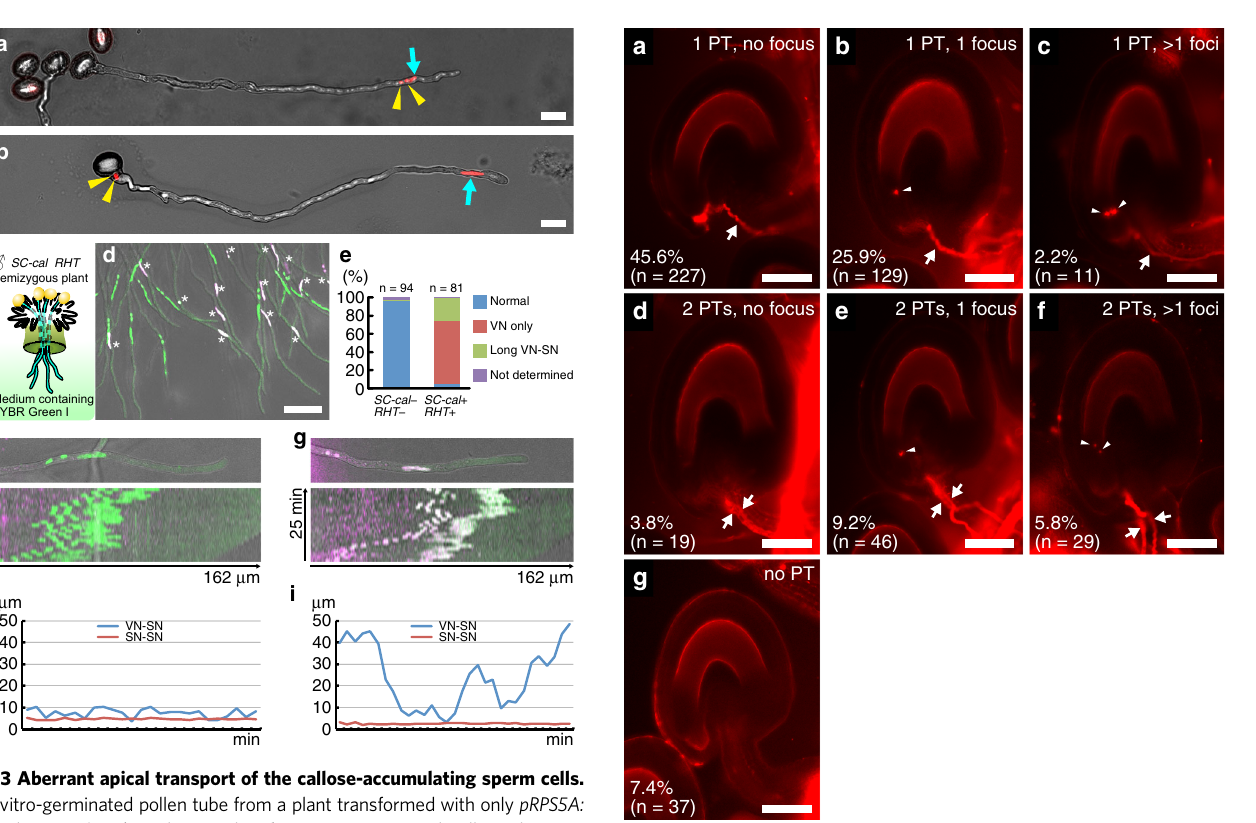
Fig. 4 Analysis of pollen-tube behavior in wild-type pistils. a – g Congo red pollen-tube staining of wild-type ovules 16 h after pollination of pollen from a double transgenic plant that carried genetically linked pHTR10:cals3m and pRPS5A:H2B-tdTomato ( SC-cal RHT hemizygous plant identical to the line used in Figs. 2 and 3). According to the number of pollen tubes (PT, arrows) entered and the number of tdTomato-labeled nuclear foci (arrowheads) at the micropyle, 498 ovules from nine pistils were classi fi ed into seven patterns. Scale bar: 50 μ m.